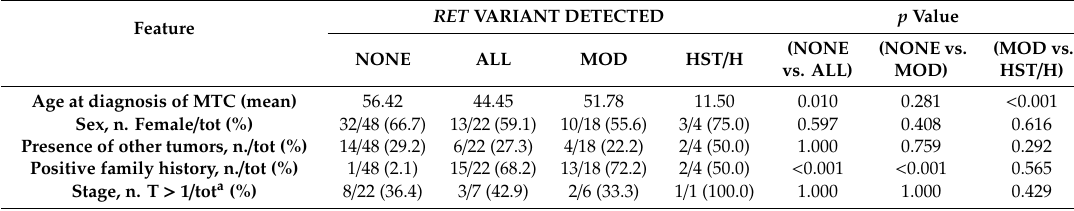
Table 2. Clinical characteristics of MTC patients according to test result.